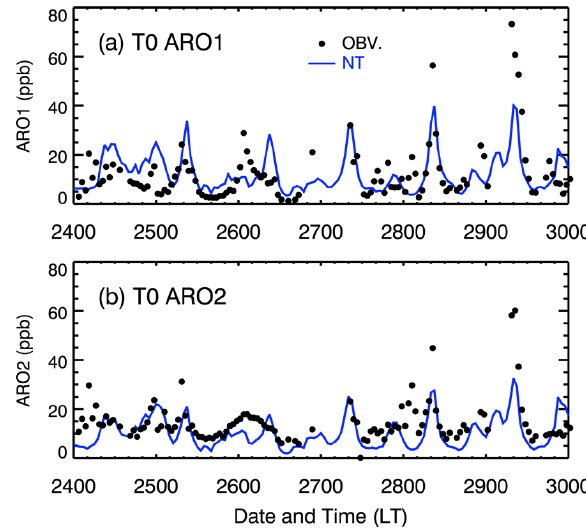
Fig. 6. Comparison of simulated (a) ARO1 and (b) ARO2 with measurements at T0 during the period from 24 to 29 March 2006. Black dots: measurements; blue line: the NT-SOA model simula- tions.